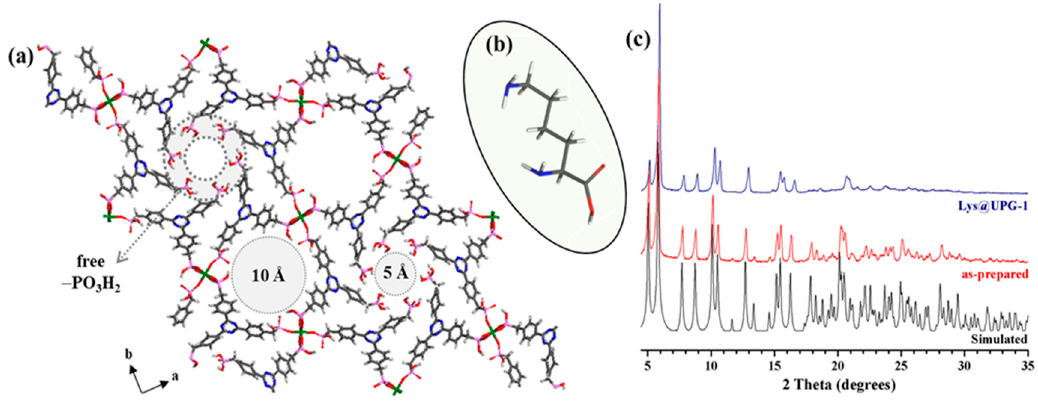
Figure 1. ( a ) Crystal structure of UPG-1 viewed along the c axis (crystallization water molecules are omitted for the sake of clarity), exhibiting the presence of the 5 and 10 Å channels and uncoordinated phosphonic acid groups (-PO 3 H 2 ). ( b ) Structural representation of lysine. ( c ) Powder X ray diffraction (PXRD) patterns of simulated and as-prepared UPG-1 and Lys@UPG-1. Color code for UPG-1 and lysine: C = dark grey, H = light grey, N = blue, O = red, P = rose and Zr = green.